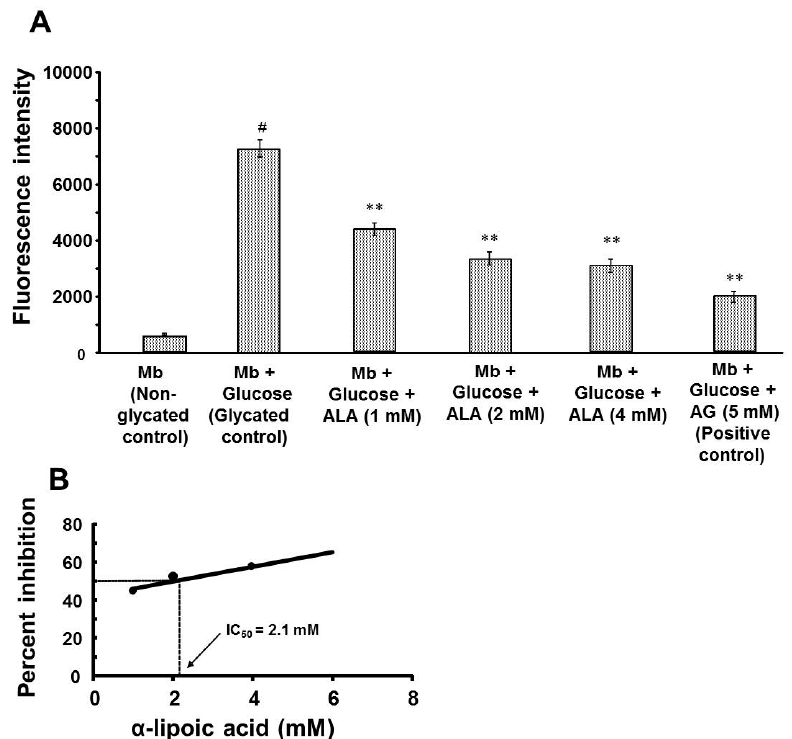
Figure 1. Effect of α -lipoic acid on the formation of fluorescent advanced glycation end products (AGEs) in glucose-induced myoglobin glycation. ( A ) Fluorescence intensity of myoglobin-glucose glycation system alone or after co-incubation with α -lipoic acid or aminoguanidine; and ( B ) The concentration of α -lipoic acid required to inhibit 50% of fluorescent AGEs as determined from linear regression analysis. Each bar represents the mean ± standard error of the mean (SEM) in six separate experiments ( n = 6); Significant difference from glycated control: ** p value < 0.01; Significant difference from non-glycated control: # p value < 0.001; ALA = ( R )- α -Lipoic acid; AG = Aminoguanidine; Mb = Myoglobin; IC 50 = concentration required to inhibit 50% of fluorescent AGEs.